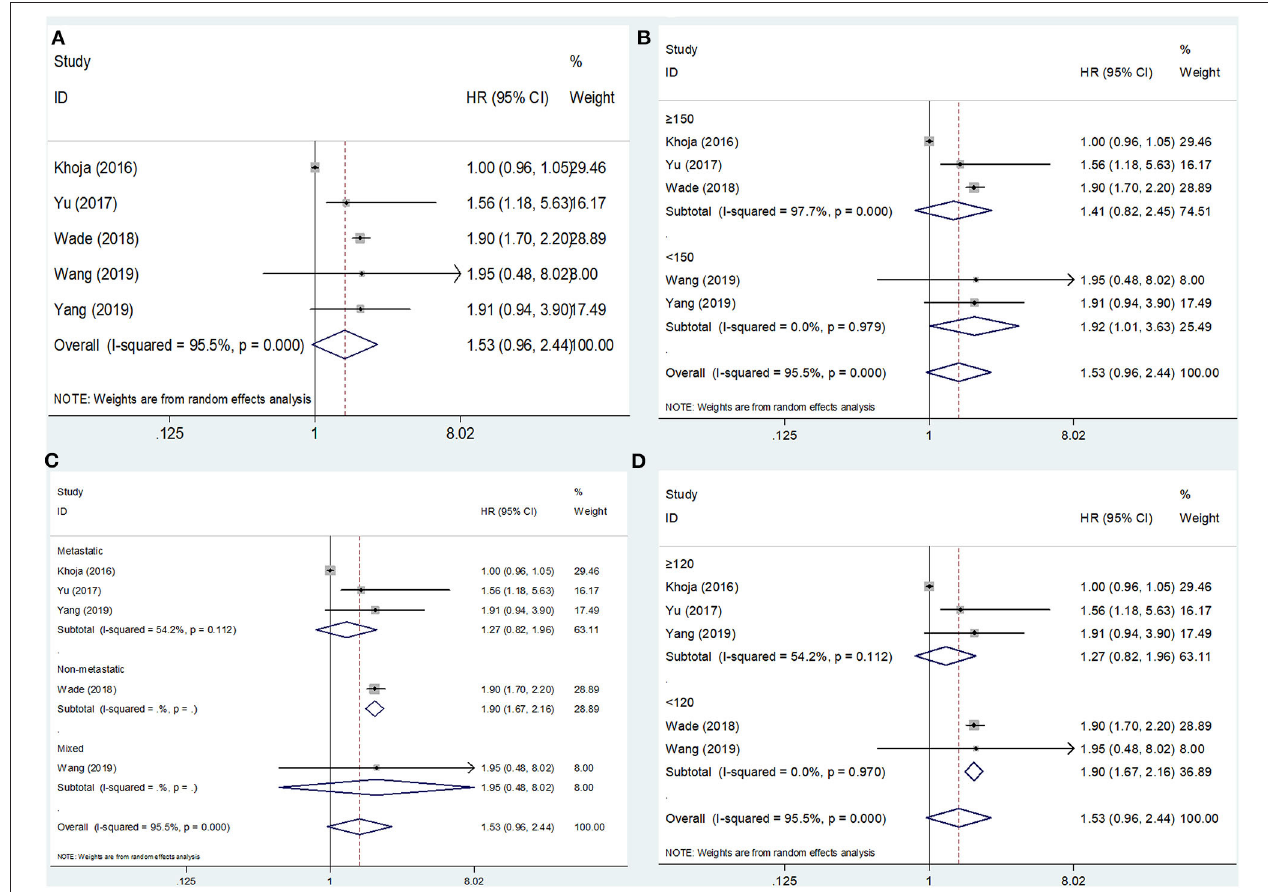
FIGURE 3 | Forest plot hazard ratio (HR) for the correlation between elevated platelet-to-lymphocyte ratio (PLR) and progression-free survival in melanoma. (A) For the total patients’ group; (B) Subgroup analysis stratified by sample size; (C) Subgroup analysis stratified by disease status; and (D) Subgroup analysis stratified by cutoff value of PLR. All analyses were performed using a random-effects